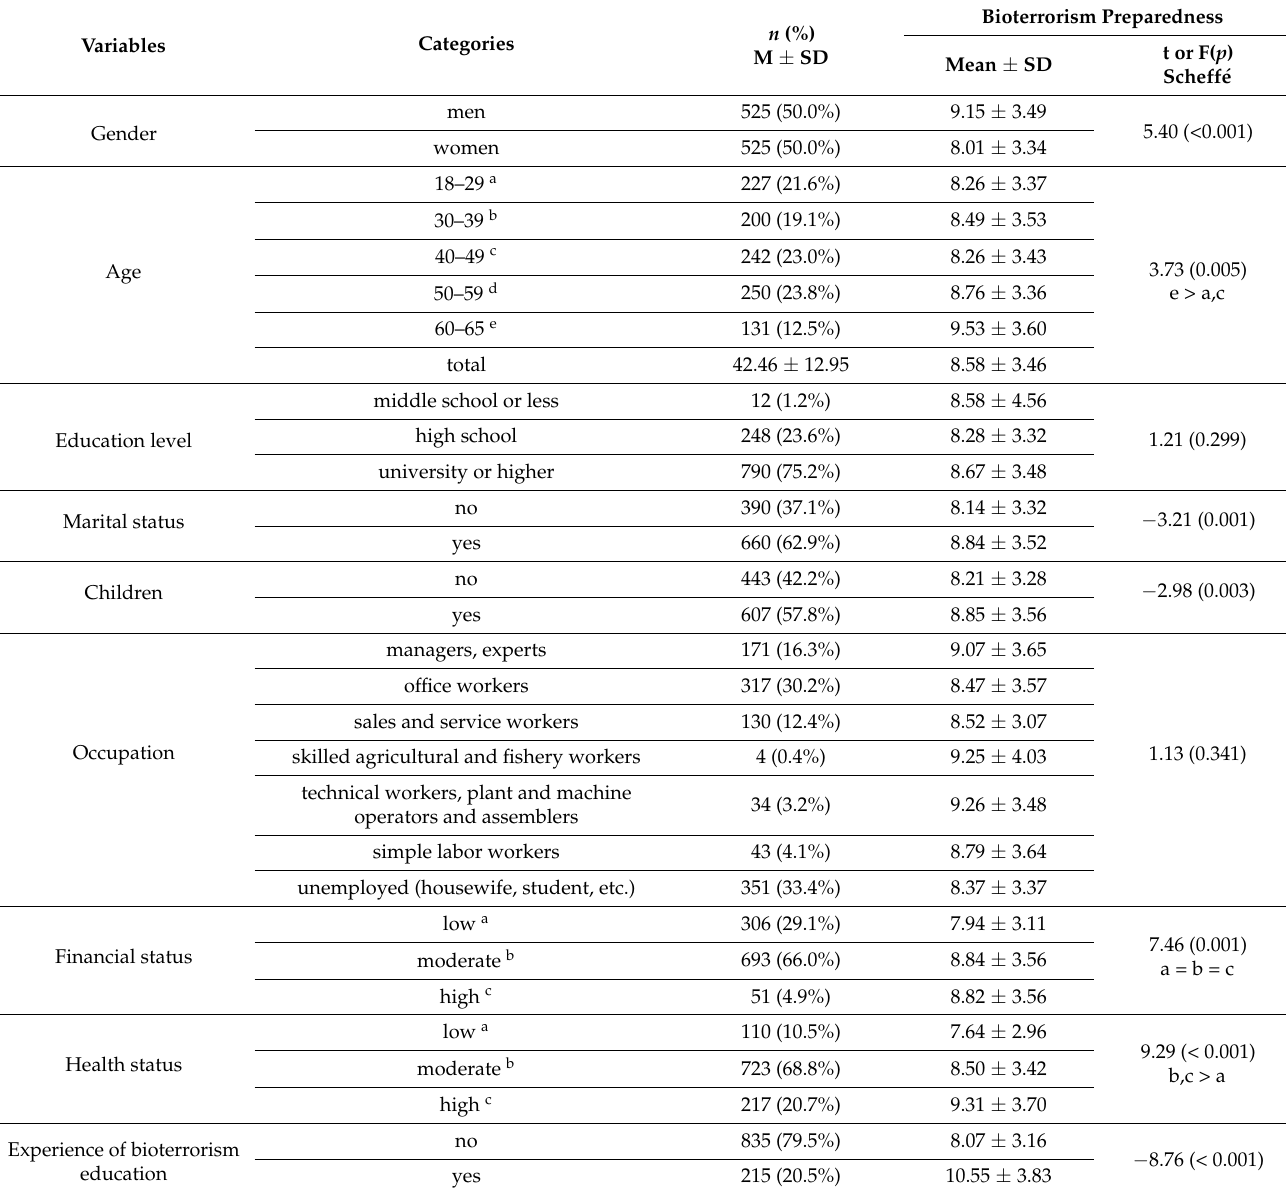
Table 1. Bioterrorism preparedness according to general characteristics of the subjects. ( N =